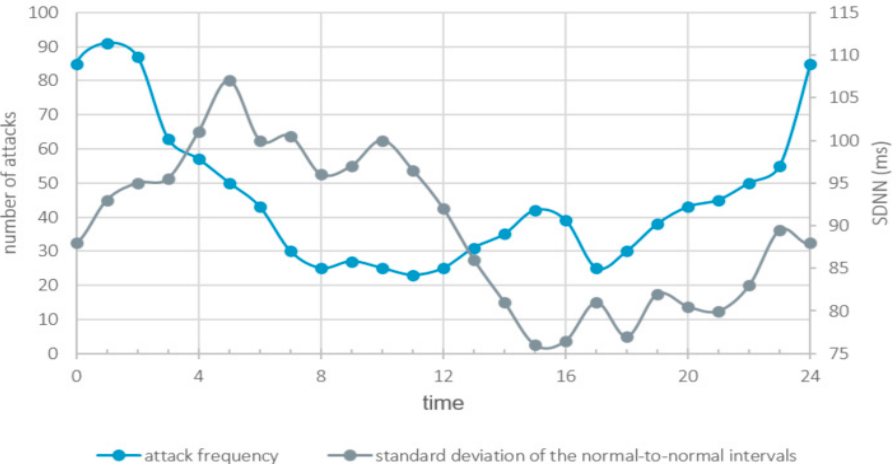
Figure 3. Correlation between time and attack frequency as well as time and the standard deviation of the normal-to-normal intervals (SDNN) in healthy adults; the left vertical axis refers to the number of attacks in a sample of cluster headache patients; the right refers to the standard deviation of the heart rate, which indicates parasympathetic innervation; data derived from Vandewalle et al. [114] and Barloese et al. [5].